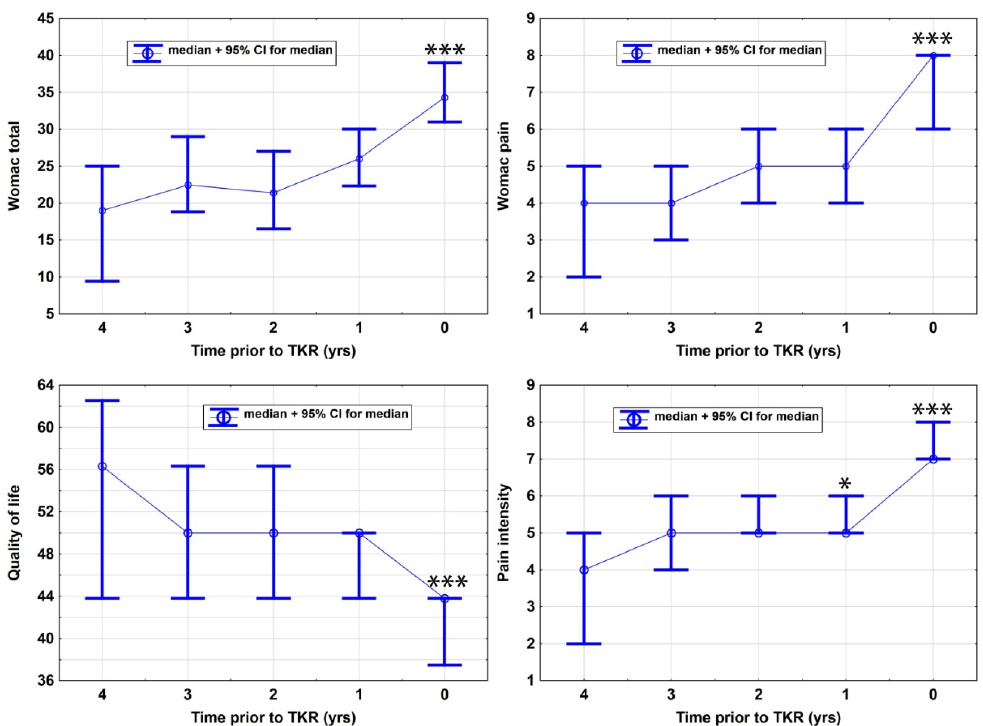
Figure 1. Panels show the longitudinal change of Western Ontario and McMaster Universities Osteoarthritis Index (WOMAC) total score [28], WOMAC pain subscore [28], pain intensity [29] and quality of life (as assessed by the knee specific Knee injury and Osteoarthritis Outcome Score (KOOS) [27]) in the years 4–0 prior to total knee replacement (TKR) (surgery. Significance levels are indicated by n.s. (not significant) or *: p ≤ 0.05, , ***: p ≤ 0.001, and represent the comparison to the previous year: